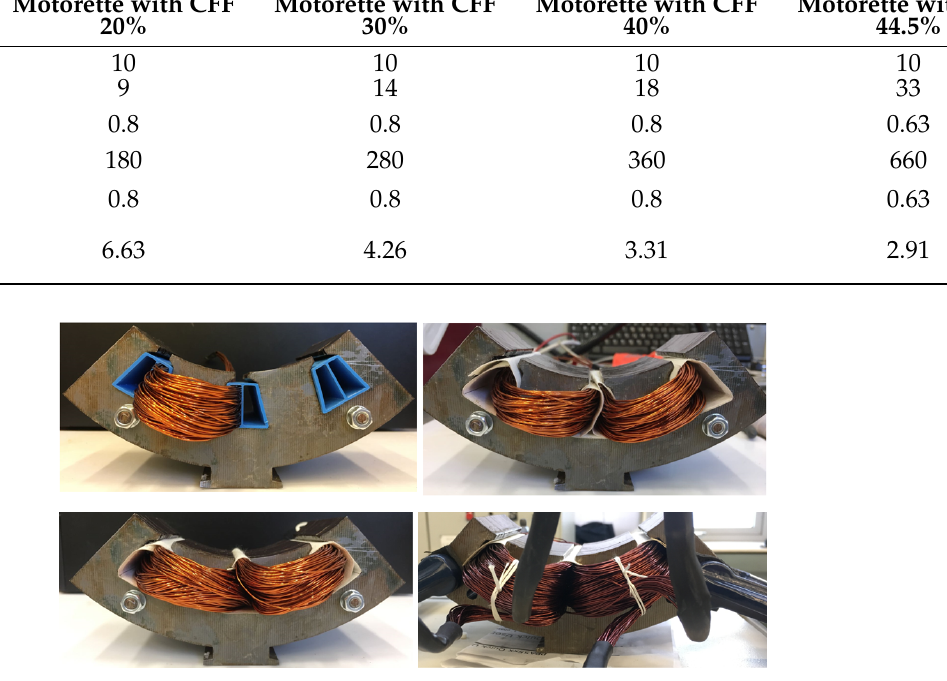
Figure 10. Experimental motorettes with varying CFF: ( Top Left ) 20% CFF; ( Top Right ) 30% CFF; ( Bottom Left ) 40% CFF; and ( Bottom Right ) motorette with 33 ‘strands-in-hand’.